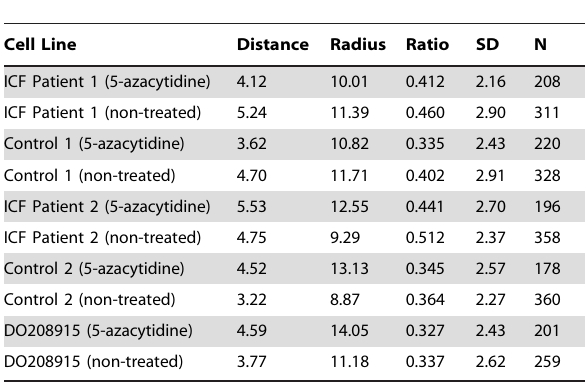
The average distance between the centroid of the chromosome 1 juxtacentromeric heterochromatin signal, as defined by hybridisation with the classical satellite DNA probe D1Z1, to the extreme nuclear periphery was measured in cells from ICF Patients 1 and 2, Controls 1 and 2, and DO208915, a third and unrelated cell line, before and after treatment with the demethylating agent 5-azacytidine (Distance=Mean Distance in m m; Nuclear Radius=Mean Nuclear Radius in m m; Ratio=Mean Distance/Nuclear Radius; SD=standard deviation; N=total number of measurements).